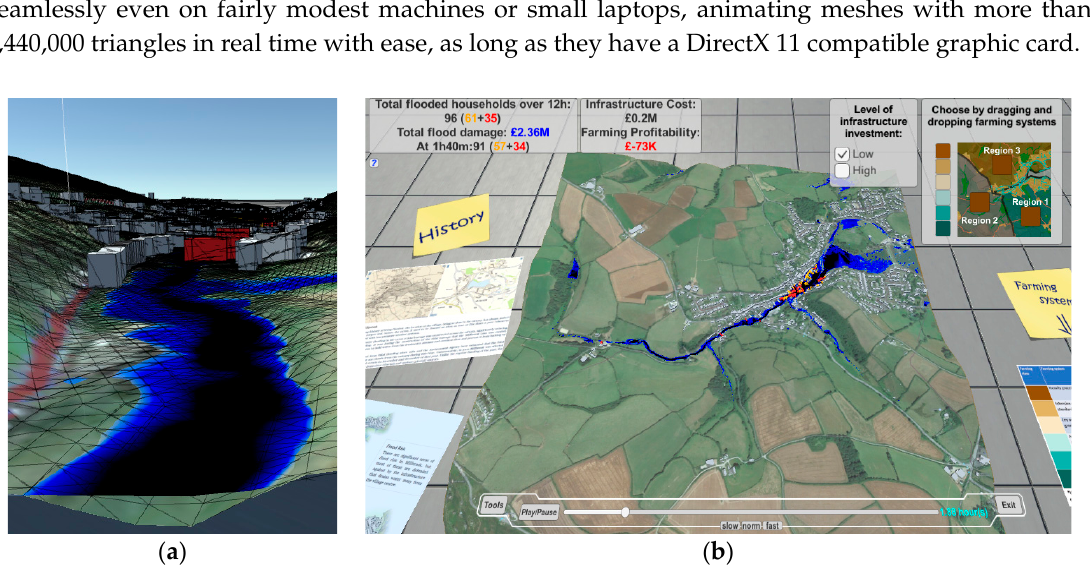
Figure 3. Shaders: ( a ) is a close up with the vertices of the mesh made visible while ( b ) is an overview of the final result.